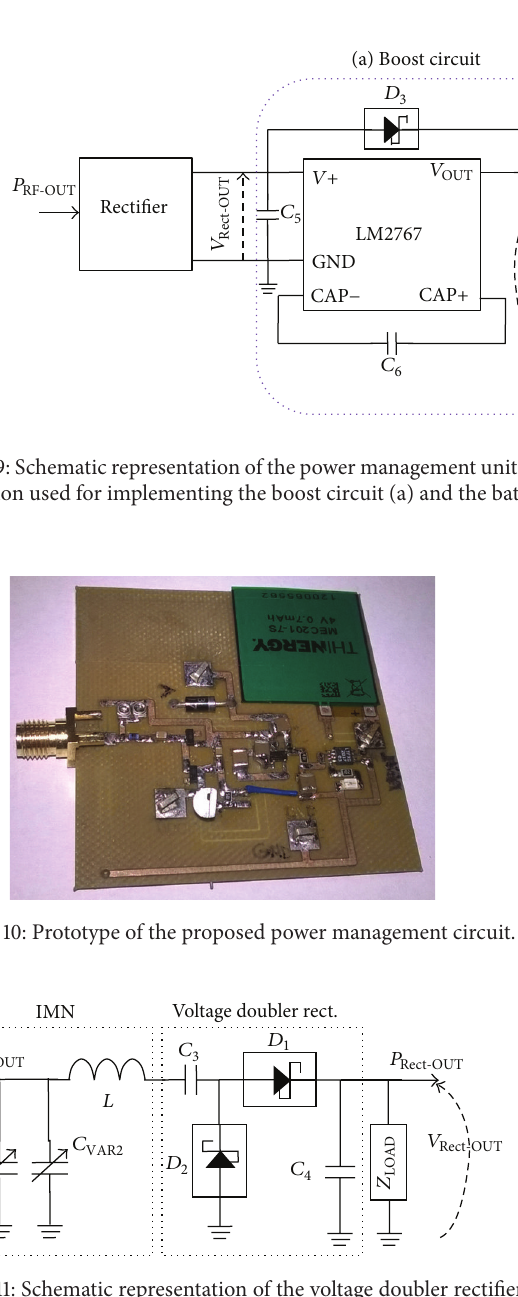
Figure 11: Schematic representation of the voltage doubler rectifier used for rectifying the RF signal.